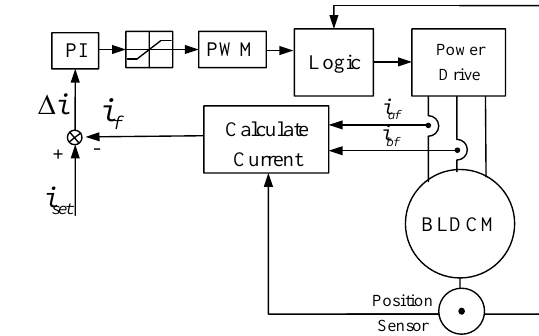
Figure 7. Control diagram of square-wave current control (SWC).